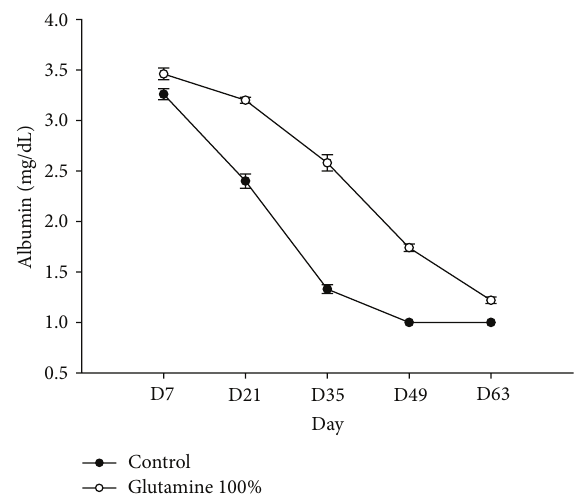
Figure 3: The mean serum albumin level was higher in the GLN- treated